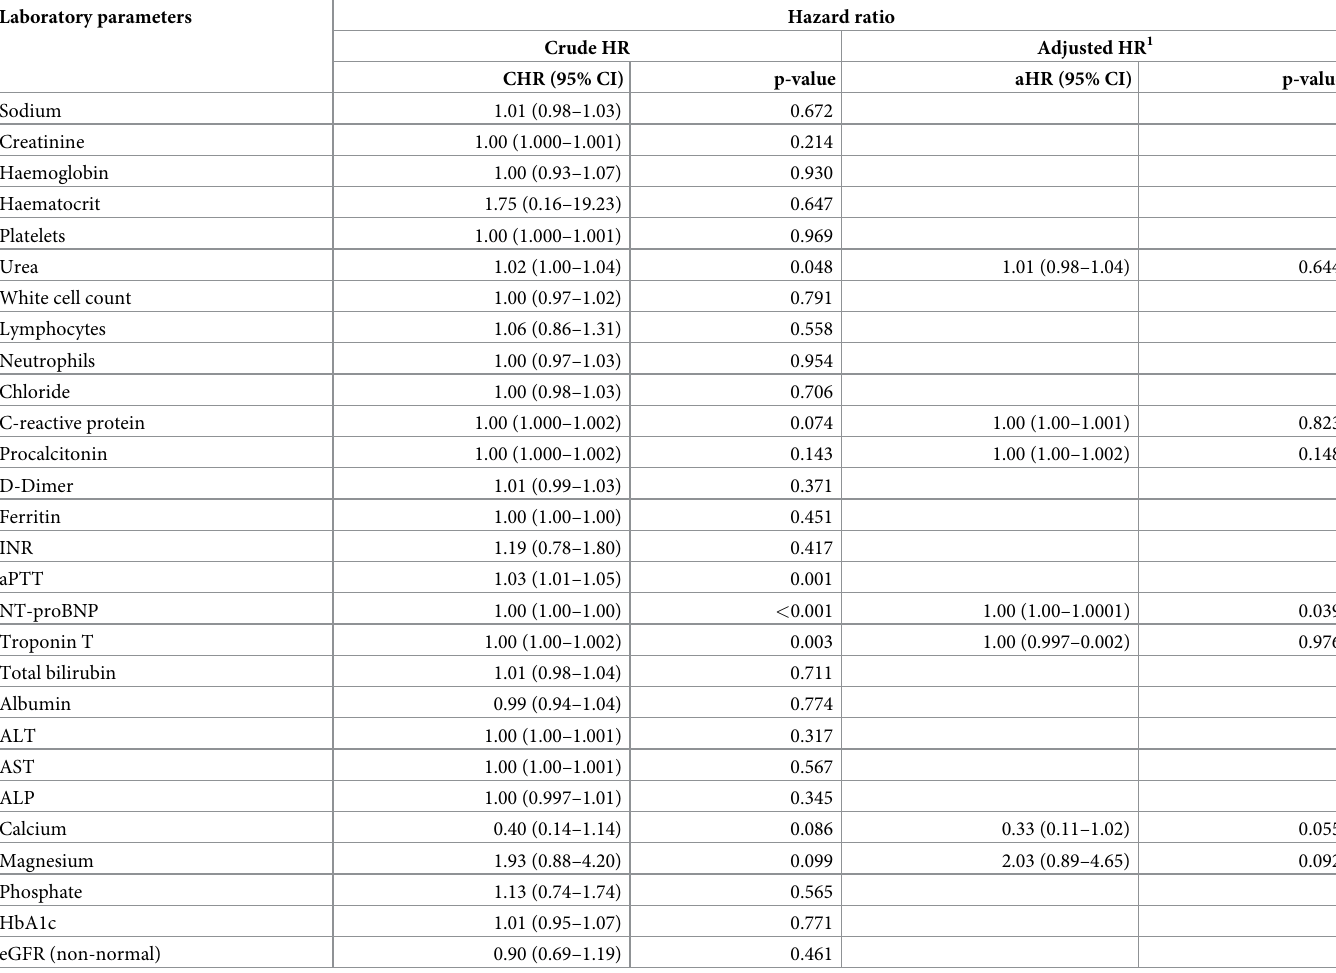
Table 6. Laboratory parameters associated with hazard ratio among COVID-19 patients admitted to ICU. Laboratory